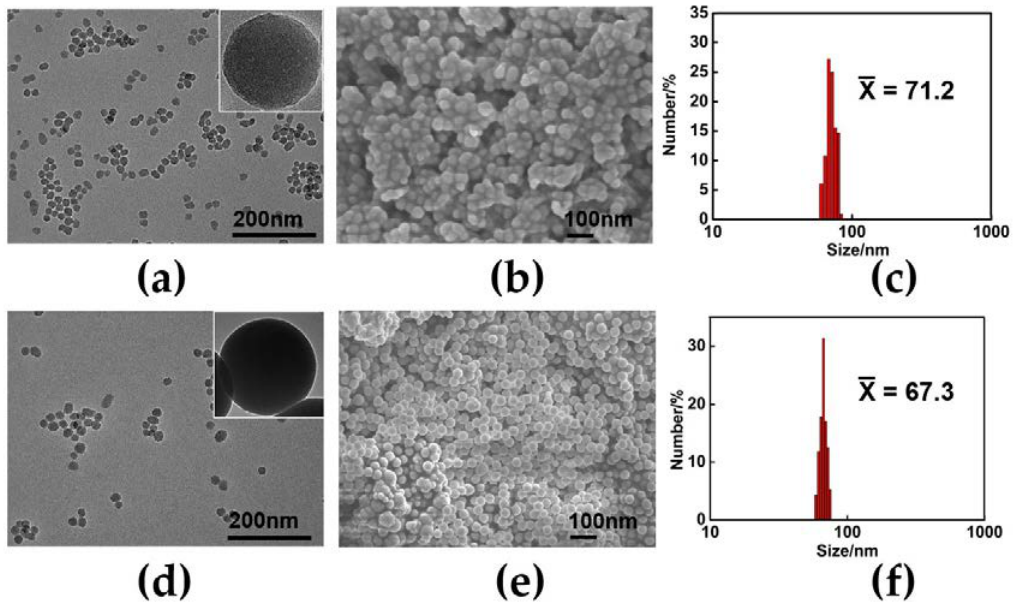
Figure 2. ( a ) TEM and ( b ) SEM images of the PTSA-SiNPs prepared with cationic polyelectrolyte poly (dimethyl diallyl ammonium chloride) (PDADMAC) as the intermediate; ( c , f ) size distribution of the PTSA-SiNPs prepared with and without PDADMAC as the intermediate, respectively; ( d ) TEM and ( e ) SEM images of the PTSA-SiNP prepared without PDADMAC as the intermediate.